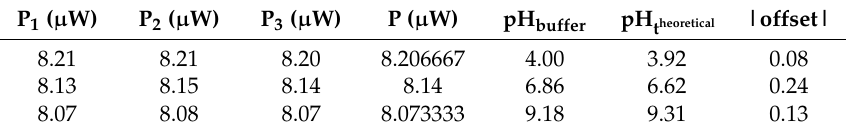
Table 3. Power response of optimized pH sensor to pH standard buffer.